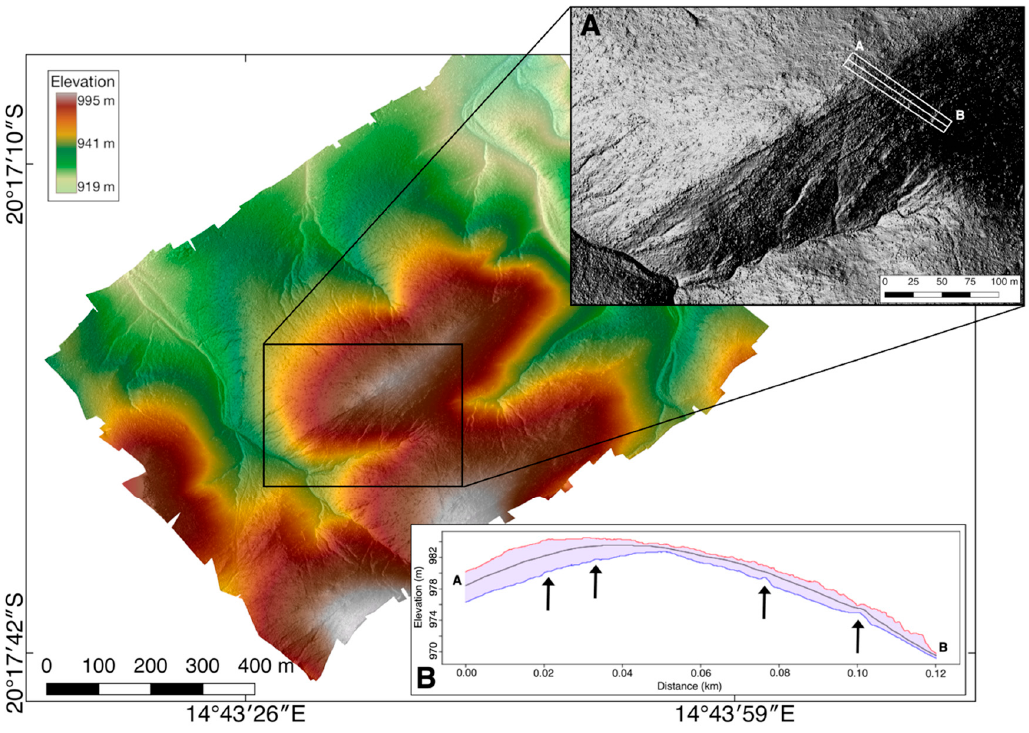
Figure 8. High-resolution Digital Elevation Model (DEM) of Area 1 (cf. Figure 6) derived from Structure-from-motion Multi-Vision-Stereo (SfM-MVS) photogrammetry with a ground resolution of 4.9 cm. Inset A shows a shaded relief section of the DEM where very fine geological structures can be discerned. Inset B shows a swath profile from points A to B, the black arrows point to possible dykes.